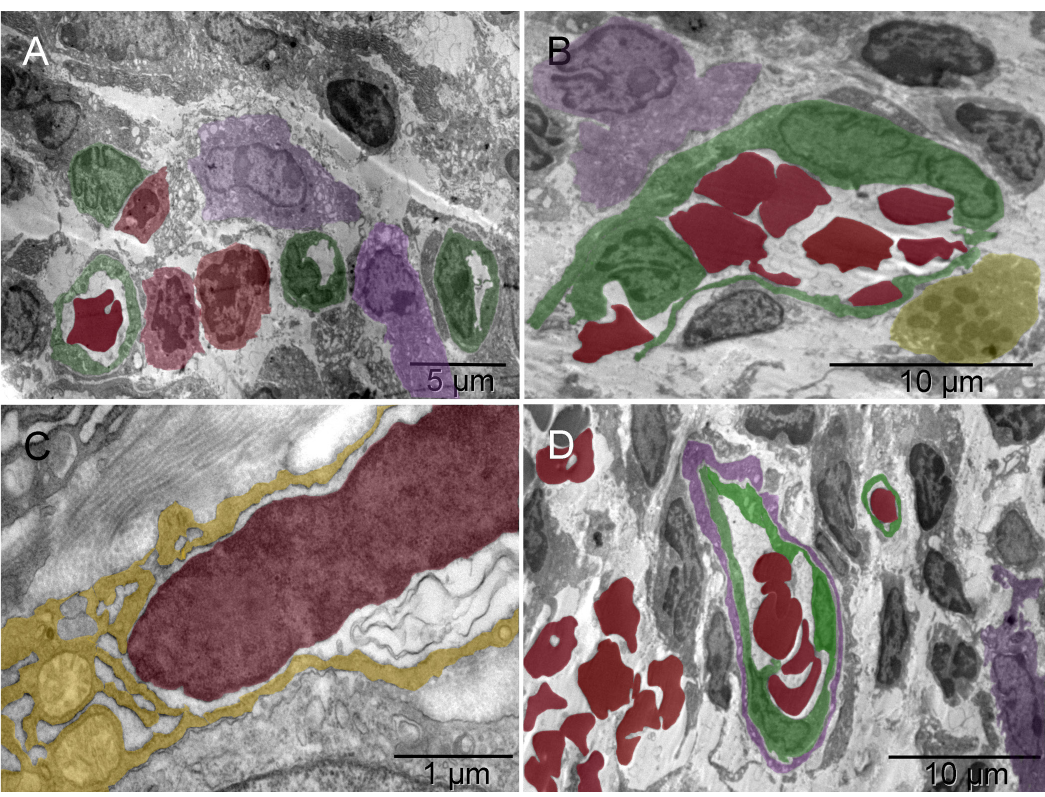
Figure S9. Progress in cellular differentiation and assembly of new vessels. Three weeks after implantation, erythroblasts (red) and megakaryocytes (purple) were accompanied by capillaries (green) [ A ]. The close proximity of those three cell types suggested their recent differentiation from common precursors (HSCs) at that location [ A ]. Also evident were forming vessels larger than capillaries, i.e. nucleated cells extending themselves around groups of erythrosomes before completing the enclosure (green) [ B ]. The snail shaped cell (purple) in the upper left corner of [ B ] had asymmetrically distributed cytoplasm (a feature of a megakaryocyte) flattened against the abluminal surface of the forming vessel like a podosome, and nucleus partially divided by a radial sinus or invagination of nuclear membrane, suggestive of a potential for stretching. Cells closer to the erythrosomes also had such features. A cell undergoing mitosis (bright yellow) is in the lower right corner of the image. Some cells, with ambivalent phenotype that had not specialized into either erythrosome or EC, made collagen in exuberant amounts, comparable to the size of their entire cytoplasm (yellow) instead of a few fibers like in Mouse 5, and the nucleus (red) seemed to be converting into an erythrosome on its own [ C ]. However, because those proficient collagen makers were also perishing in the process of tissue building, the result was an area filled with scattered erythrosomes amidst massive amounts of collagen like in the left lower corner in [ D ]. Capillaries and larger vessels were seen side by side [ D ].